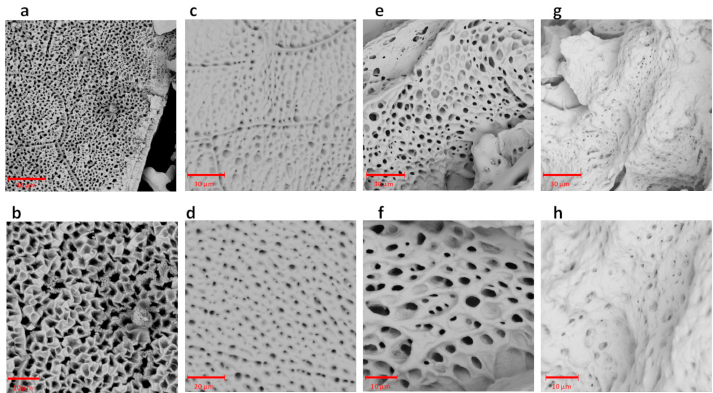
Figure 2. SEM images of γ -PGA-based hydrogels with various cross-linkers. ( a , b ) PEG200; ( c , d ) PEG400; ( e , f ); and ( g , h ) PEG1000-3arm at 5